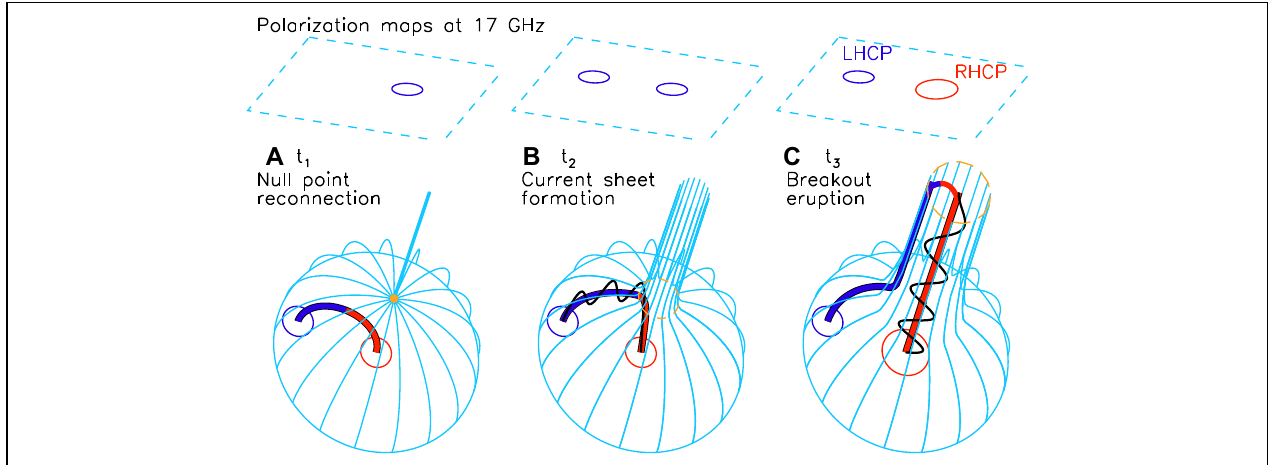
FIGURE 8 | Schematic illustration of the three stages of the event evolution: (A) nullpoint reconnection, (B) nonthermal activation, and (C) breakout eruption. Top panels: microwave polarization maps on the projected sky plane showing LHCP (blue) and RHCP (red). Bottom panels: magnetic structural evolution showing the fan-spine field (cyan), the flaring loop with magnetic polarities distinguished in color, and the Alfvén waves (black wavy curves) as well as the null point (orange dot), BCS (orange dashed circle), inner ribbon (red circle) and circular ribbon (cyan circle). (Source: Lee et al.,